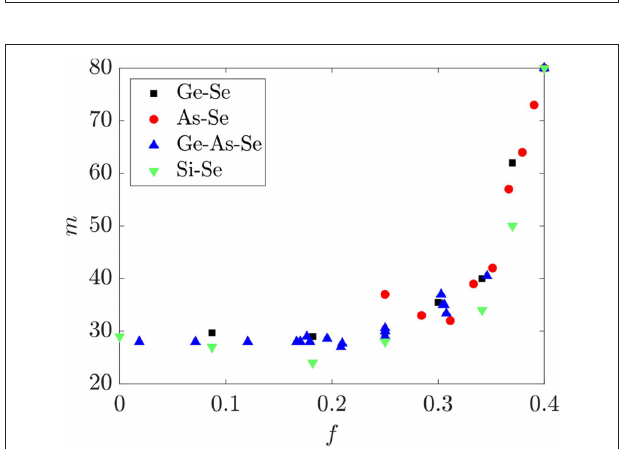
FIGURE 8 | The fragility m for binary Ge-Se, As-Se, Si-Se and ternary Ge-As-Se glasses as a function of the fractional degrees of freedom f . Fragility data are from Bernatz et al. (2002), Koštál and Málek (2010), Gueguen et al. (2011), Musgraves et al. (2011), Wang et al. (2014), Svoboda and Málek (2015) , Marple et al.